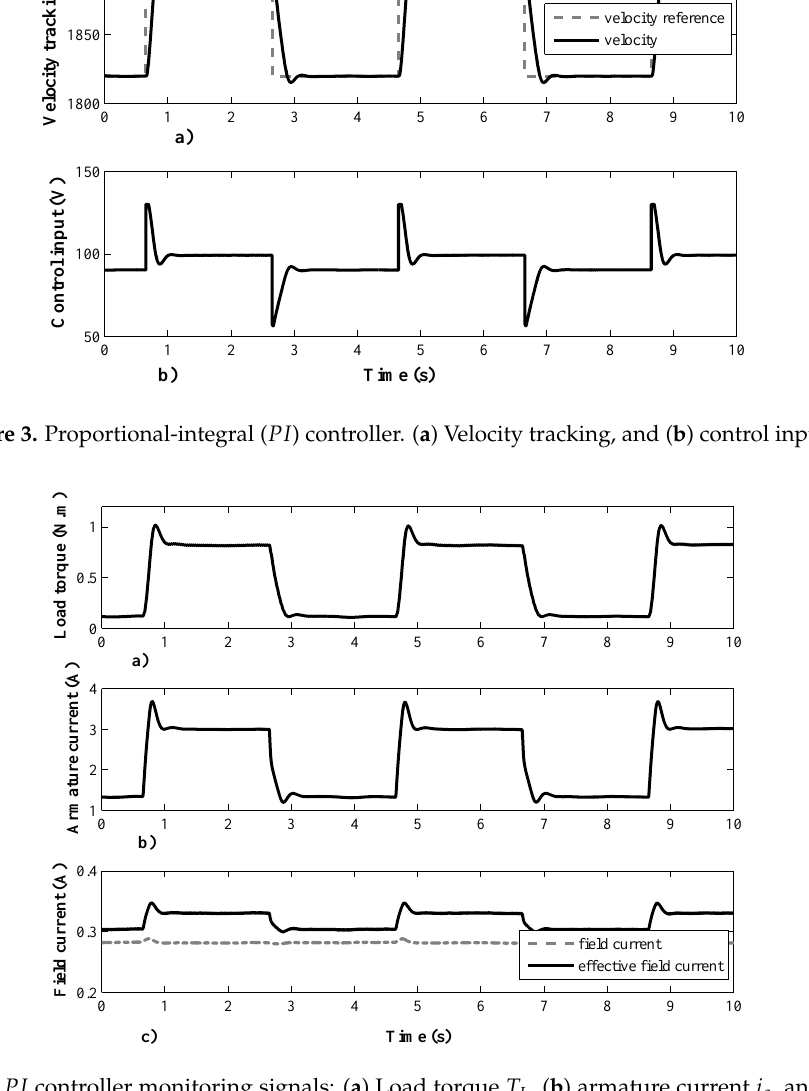
Figure 4. PI controller monitoring signals: ( a ) Load torque T L , ( b ) armature current i a , and ( c ) field current i f and effective field current i ef f